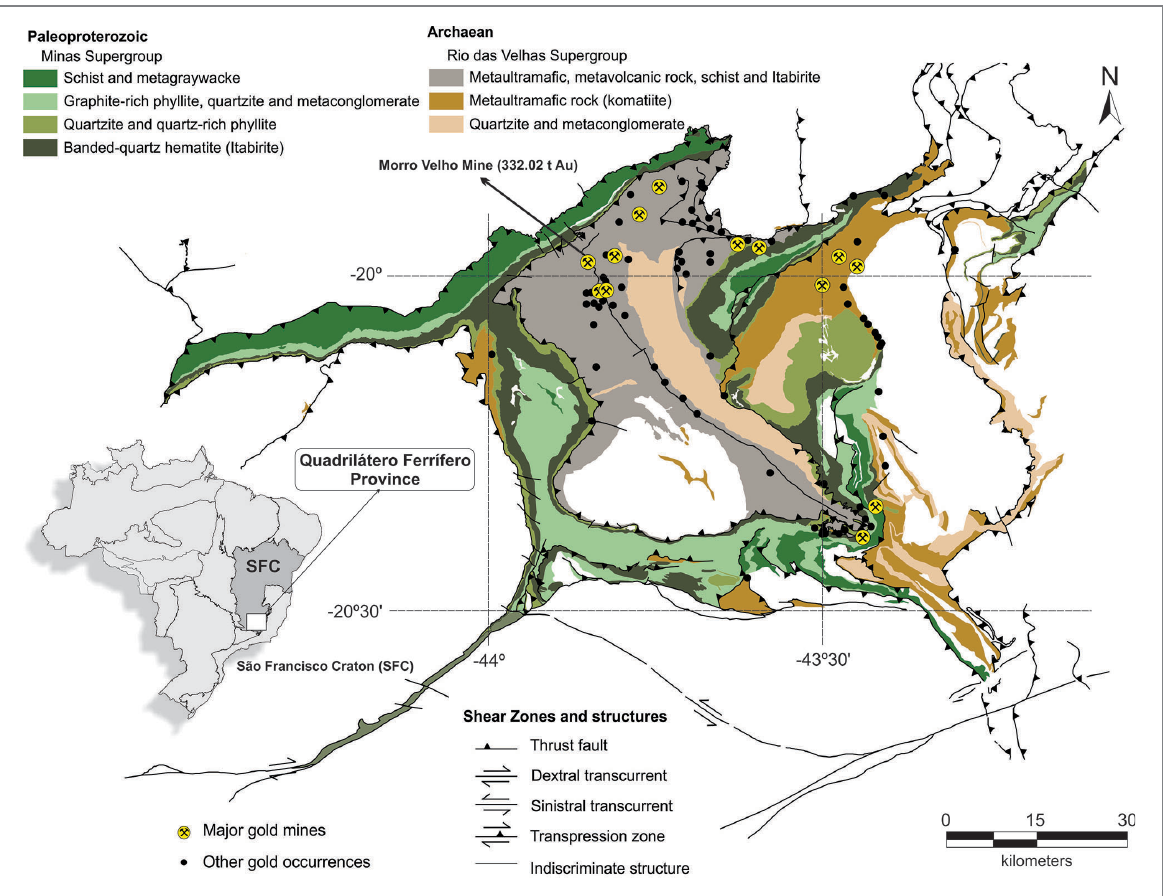
FIGURE 1 – Simplified geological map of the Quadrilátero Ferrífero Province, with emphasis on the Rio das Velhas Supergroup and the Minas Supergroup. Yellow filled circles represent the mines listed in this work (see Table 1). The black dots represent the other known occurrences and small mine sites (modified from CPRM, CODEMIG